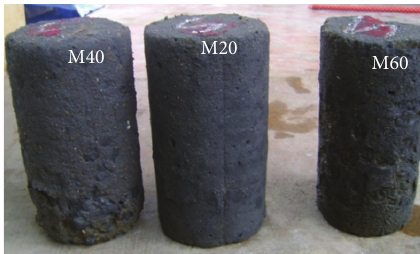
Figure 4: Geopolymer specimens exposed to 2% sulphuric acid solution.